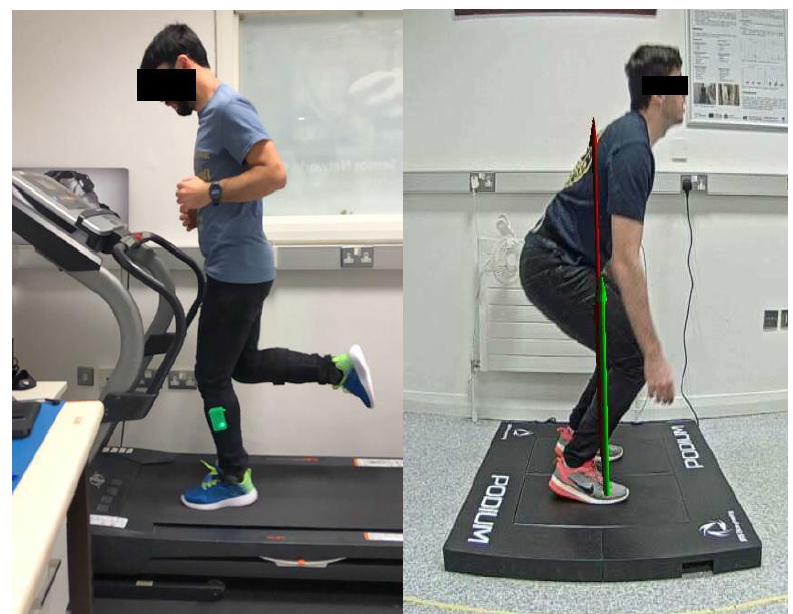
Figure 14. Data collection during running ( left ) and jumping ( right ).